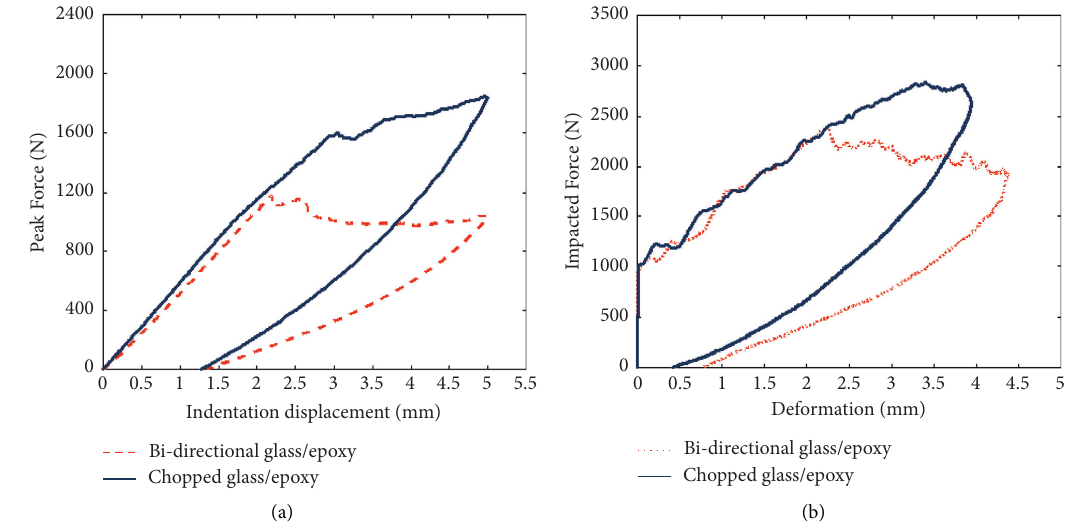
Figure 3: Force-displacement response of bidirectional and chopped glass/epoxy laminates: (a) QSI and (b) LVI loading.